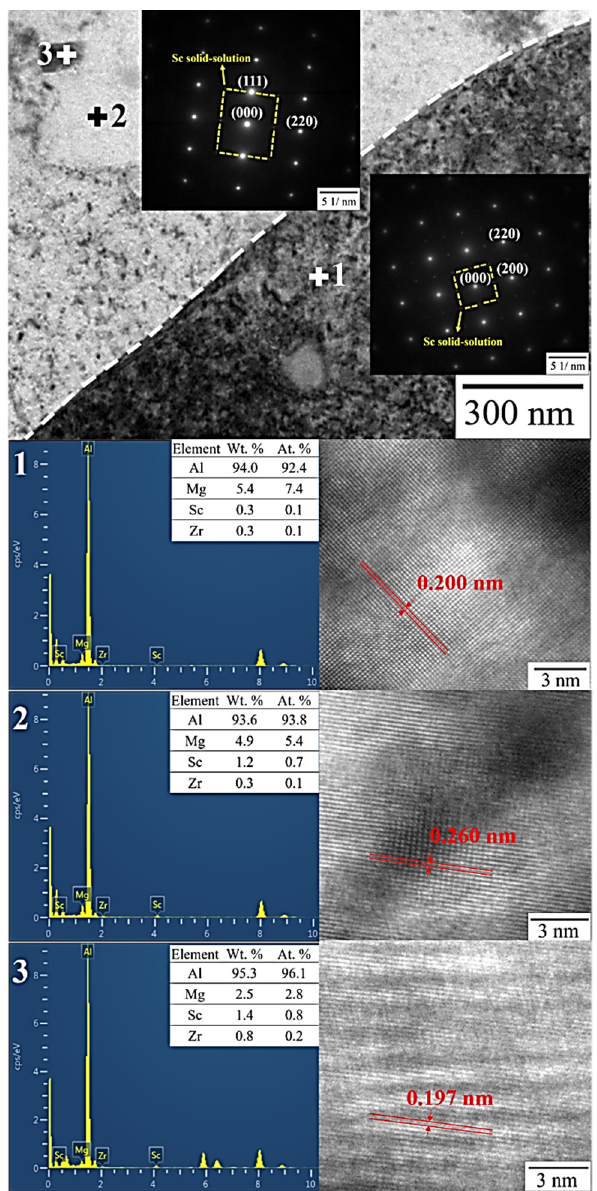
Figure 13. TEM data of two-stage-heat-treated matrix (point ( 1 ): Al–Mg particle; point ( 2 ): α -Al matrix; point ( 3 ): Al 3 Sc precipitation phase).